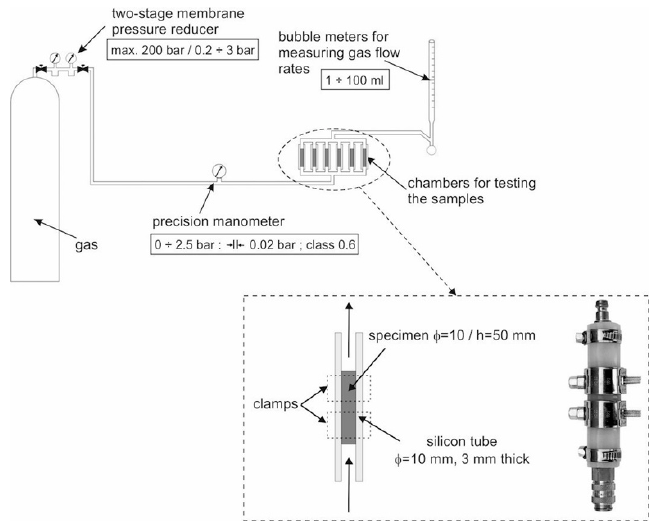
Figure 1. RILEM-Cembureau gas permeability measurement apparatus and details of specimen fixing in a silicon tube chamber [38].